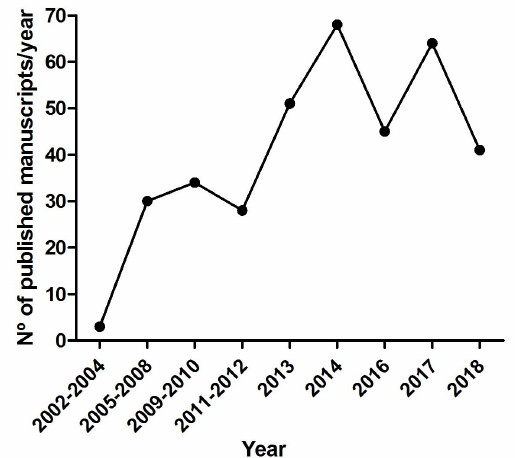
Figure 4. Number of scientific manuscripts on MSC-based clinical trials published over time. Timeline of published scientific articles about registered clinical trials using MSCs. The research was done in PubMed database using the terms “mesenchymal stem cell” OR “mesenchymal stromal cell” and selecting “clinical trials” as article